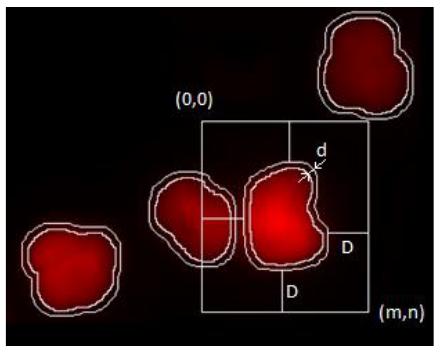
Figure 1. Method of background intensity measurement: the resolution of the system is visible; the objects are only tens of pixels in size.